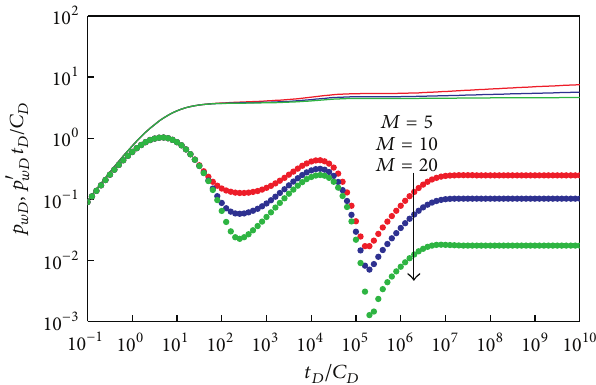
Figure 10: Effect of total branch level ( 𝑀 ) on type curves ( 𝛼 = 1 , = 10 m, 𝑑 = 0.05 m, 𝐷 𝛽 = 0.65 , 𝜃 = 1 , 𝑁 = 4 , 𝑀 = 10 , 𝑙 0 0 = 4 , 𝑟 = 0.1 m, 𝑆 = −1 , 𝐶 = 0.0001 , ℎ = 10 m, 𝐶 𝑇 𝑚 𝑤 𝐷𝑒 = 1 × 10 −4 MPa −1 2.2 × 10 −5 MPa −1 , and 𝐶 𝑓𝑡